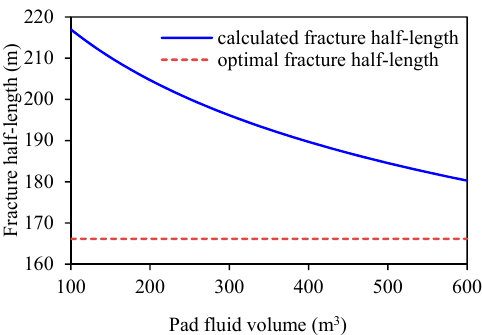
Figure 4. Curves of propped fracture half-length vs. pad fluid volume for the original design.